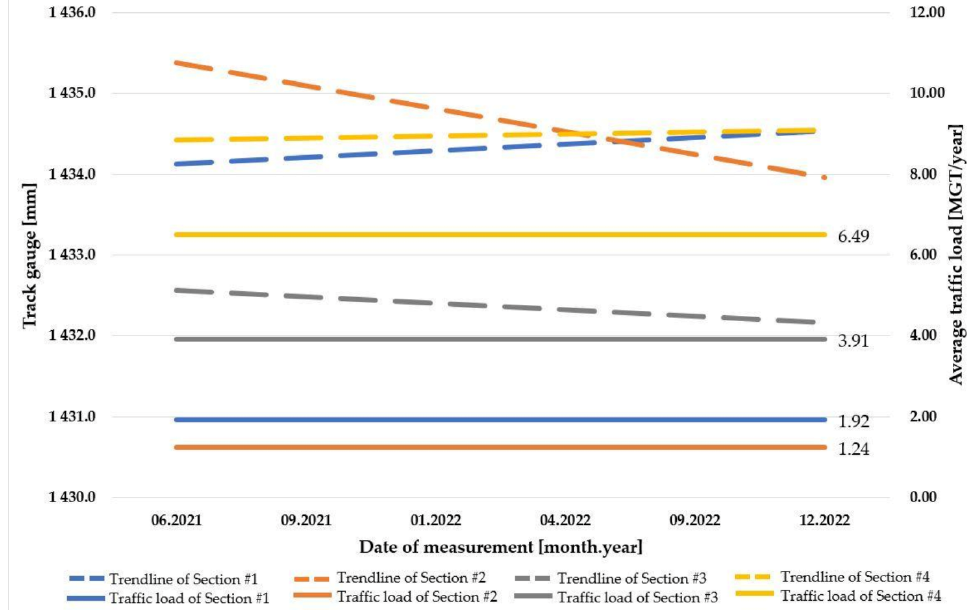
Figure 24. The relationship between track gauge and traffic load in ballasted track